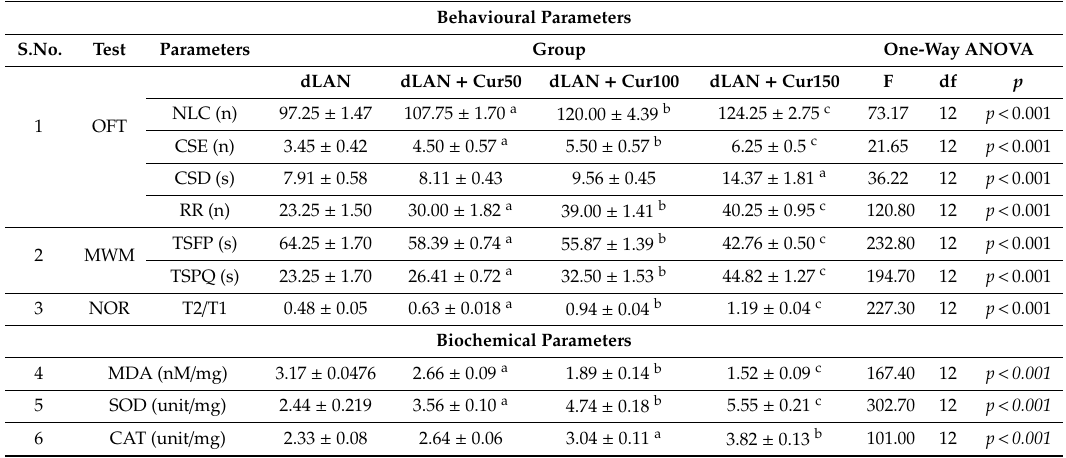
Table 2. E ff ect of curcumin on dLAN induced behavioural and biochemical alterations in mice. Behavioural